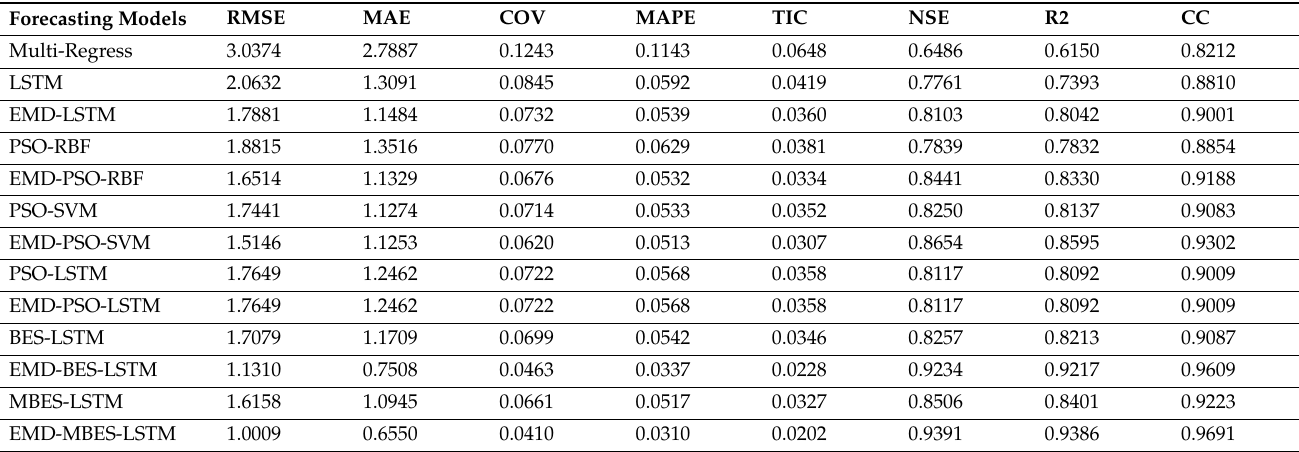
highest performance indexes. Table 10. Comparison of evaluation metrics. Table 10. Comparison of evaluation